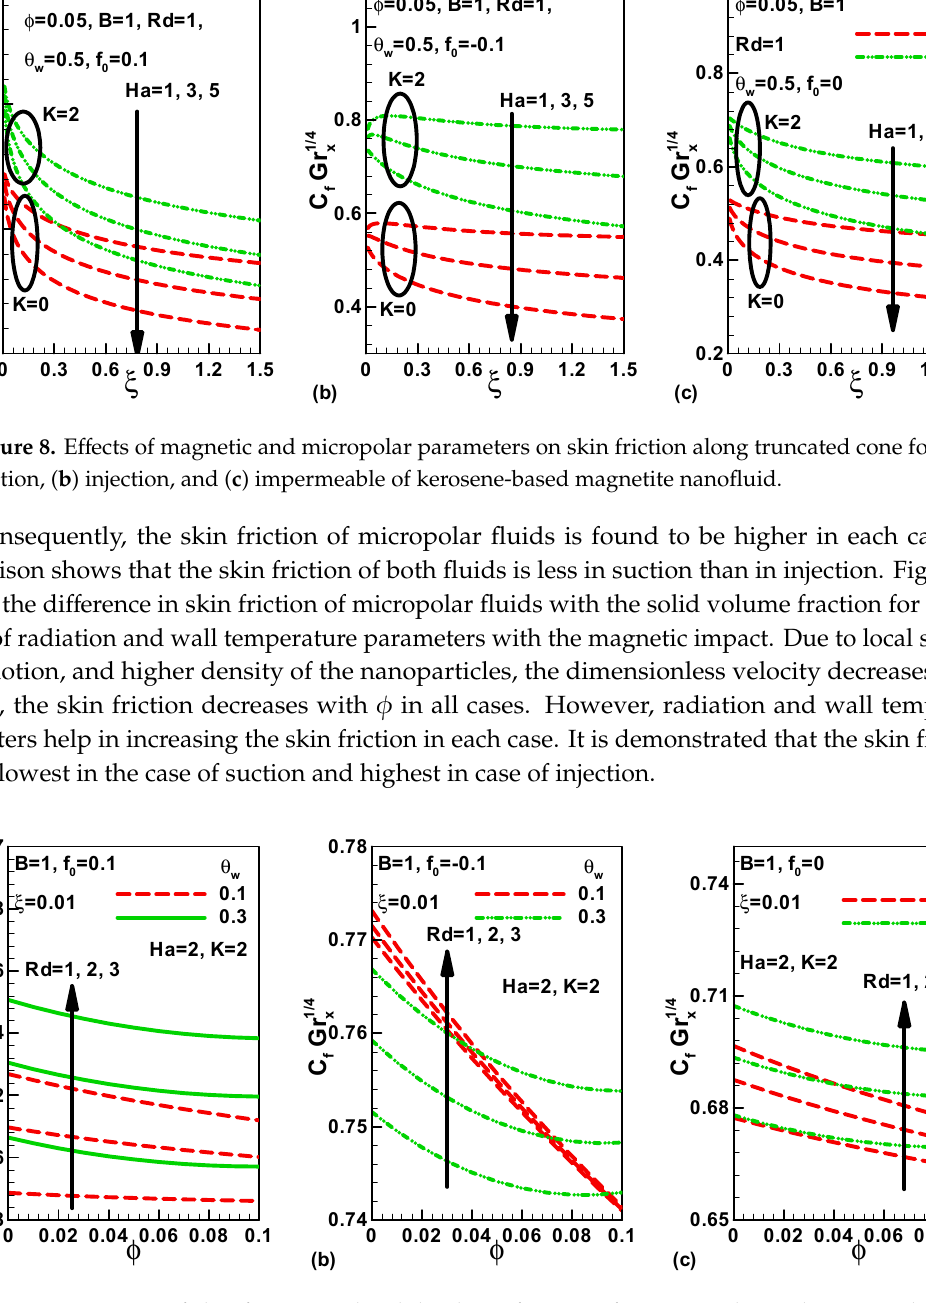
Figure 10. Effects of magnetic and micropolar parameters on Nusselt number along truncated cone for ( a ) suction, ( b ) injection, and ( c ) impermeable of kerosene-based magnetite nanofluid.